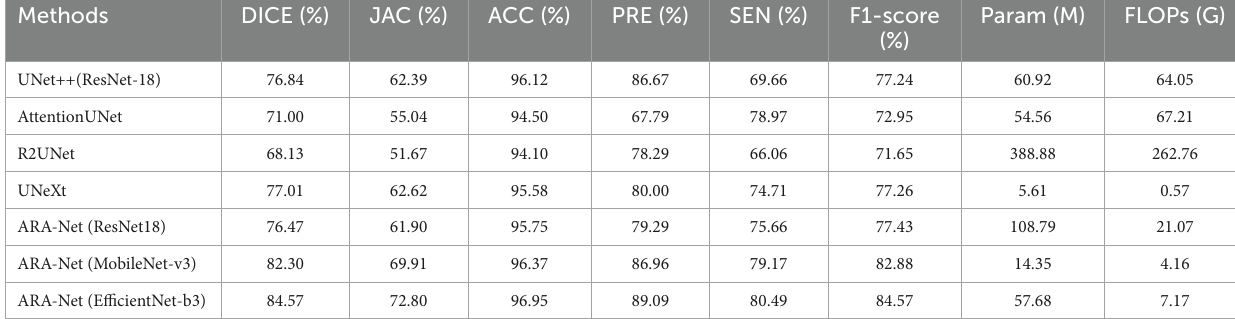
TABLE 4 Comparison of segmentation performance, number of parameters, and FLOPs of different methods.